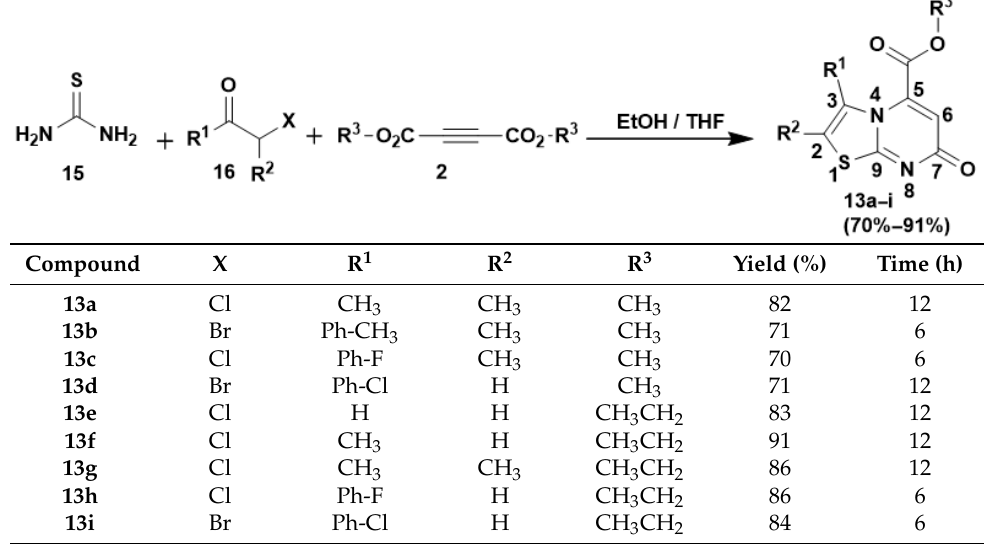
Scheme 4. Proposed reaction mechanism for the formation of compounds 13a–j . Table 3. Isolated yields of 13a–i from one-pot, three-component reaction. Table 3. Isolated yields of 13a–i from one-pot, three-component reaction.